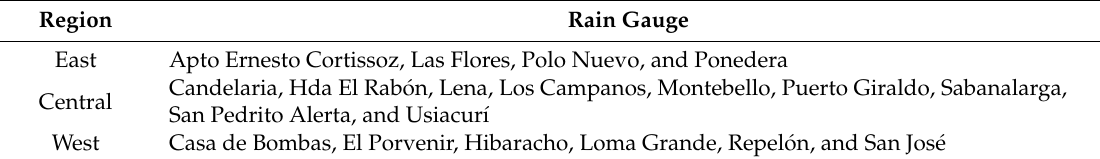
Figure 5. Delimited homogeneous zones. Table 6. Homogeneous regions and corresponding rain gauges.